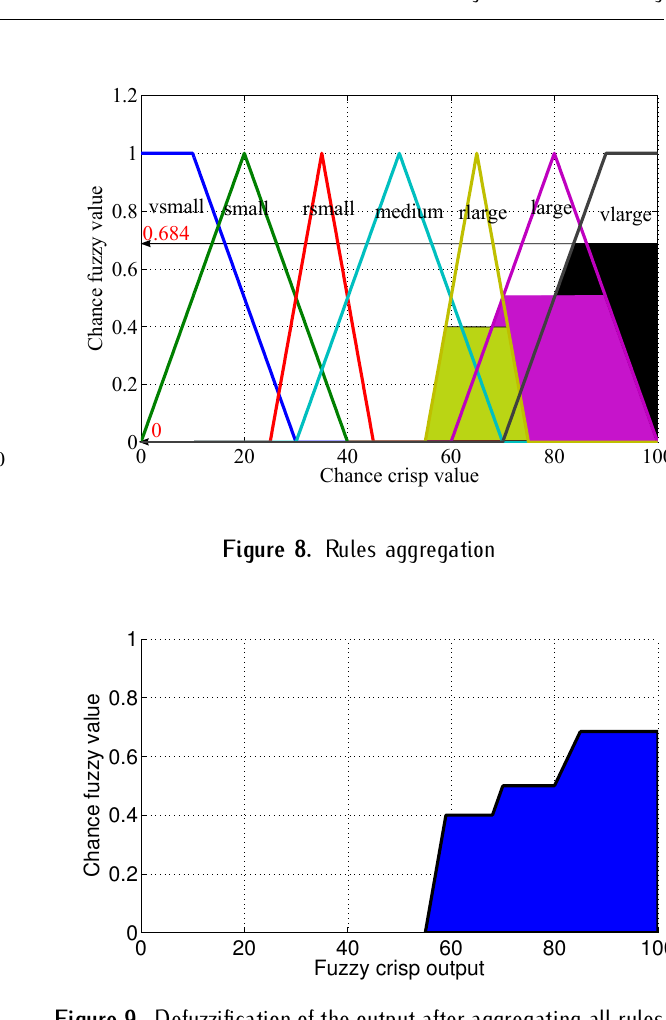
Figure 9. Defuzzification of the output after aggregating all rules from Fig. 8 Type 1 production rule is used producing 3 3 = 27